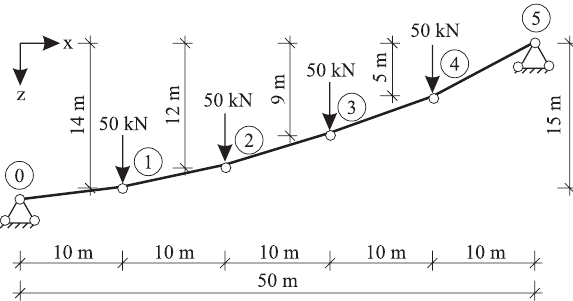
Fig. 4. Design scheme of the cable structure in the initial balance